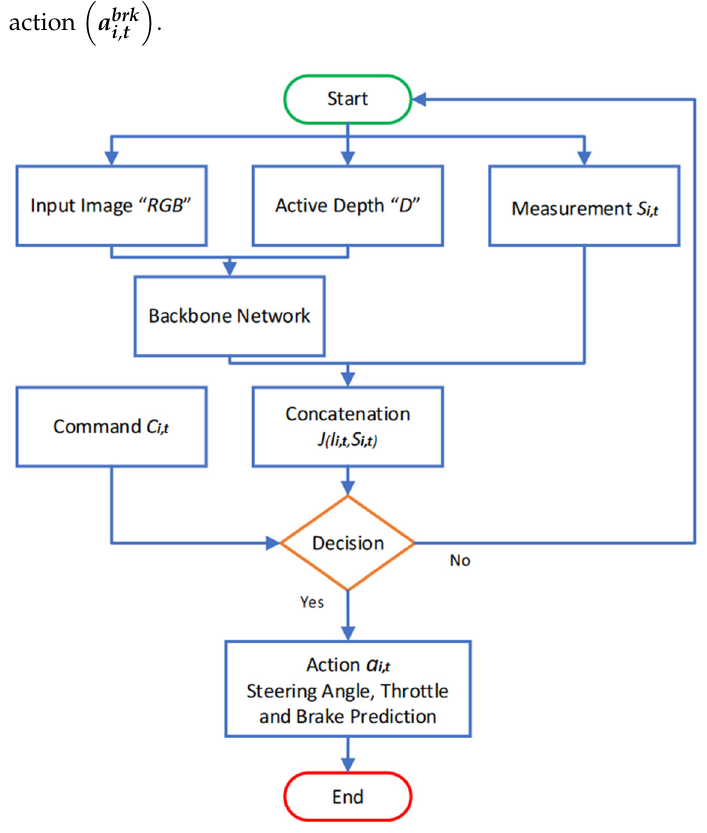
Figure 3. A Pipeline of the Early Fusion of the Multi-Model Network.